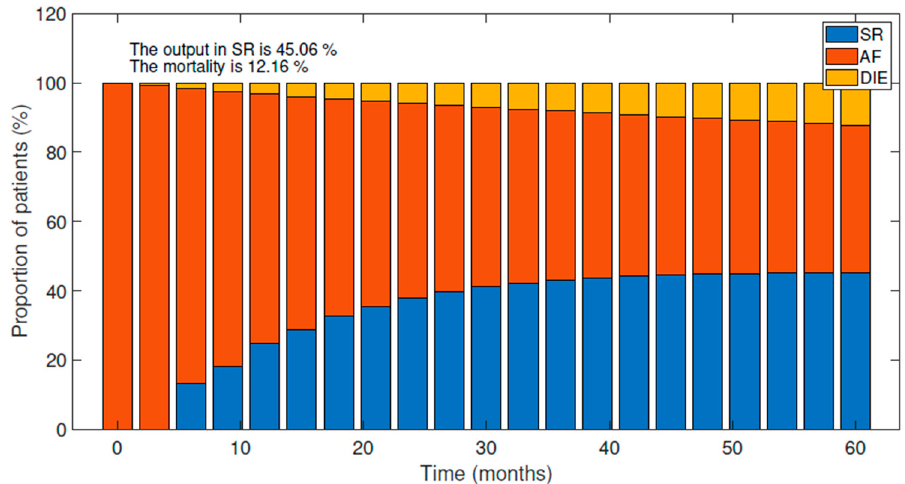
Figure 2. Evolution of the current situation of the AF population after five years. Variations between SR, AF, and Death.